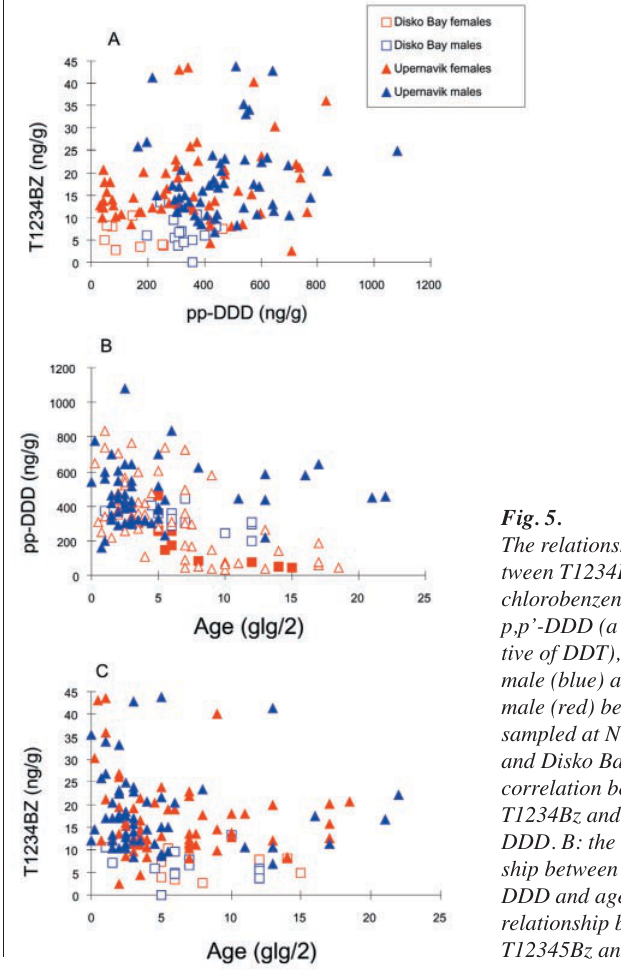
The relationships be- tween T1234Bz (a chlorobenzene), and p,p’-DDD (a deriva- tive of DDT), age and male (blue) and fe- male (red) belugas sampled at Nuussuaq and Disko Bay. A: the correlation between T1234Bz and p,p’- DDD. B: the relation- ship between p,p’- DDD and age. C: the relationship between T12345Bz and